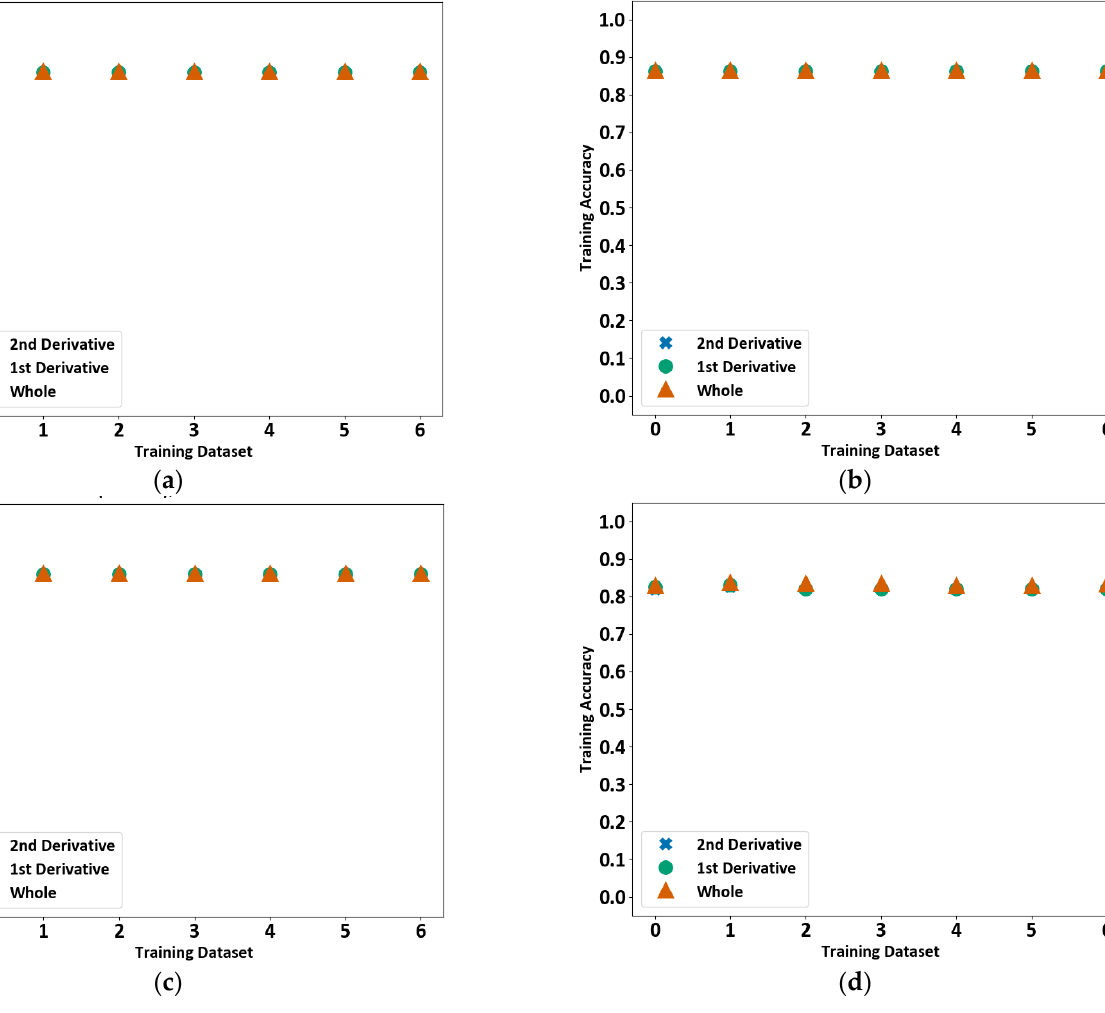
Figure 11. Support vector classification training accuracy for each file. The training accuracy for SVC using a bagging classifier for two class ( a ), SVC using a bagging classifier for four class ( b ), SVC normal for two class ( c ), and SVC normal for four class ( d ) are shown.